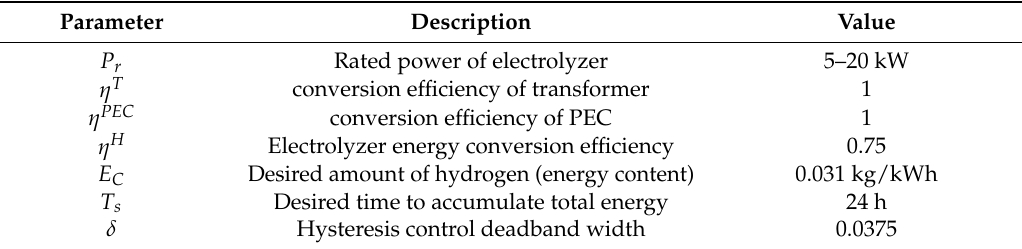
Table A1. Parameters for the device-level simulation of supply and demand side electrolyzers.